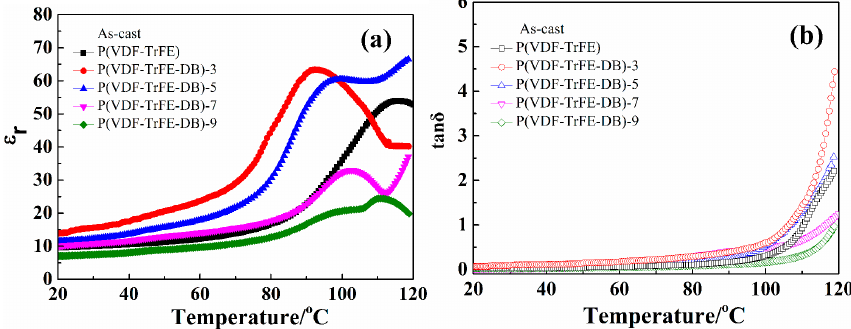
Figure 6. Dielectric permittivity ( a ) and dielectric loss ( b ) as a function of temperature at 1 kHz for the as-cast P(VDF-TrFE) and P(VDF-TrFE-DB)s. as-cast P(VDF-TrFE) and